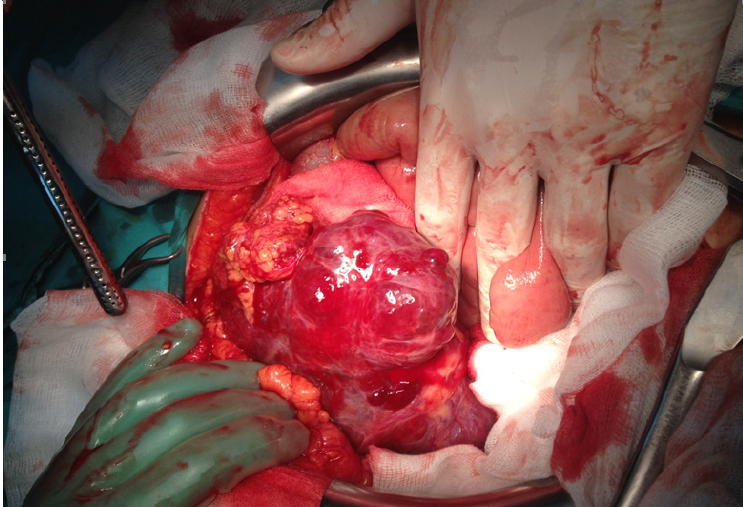
Figure 2. Hemorrhagic Cystic Type of Neoplasm Was Found in the Right Hypochondrium